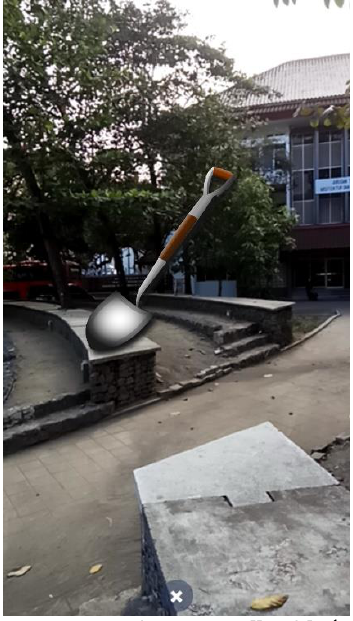
Figure 7. AR camera showing a collectible (a